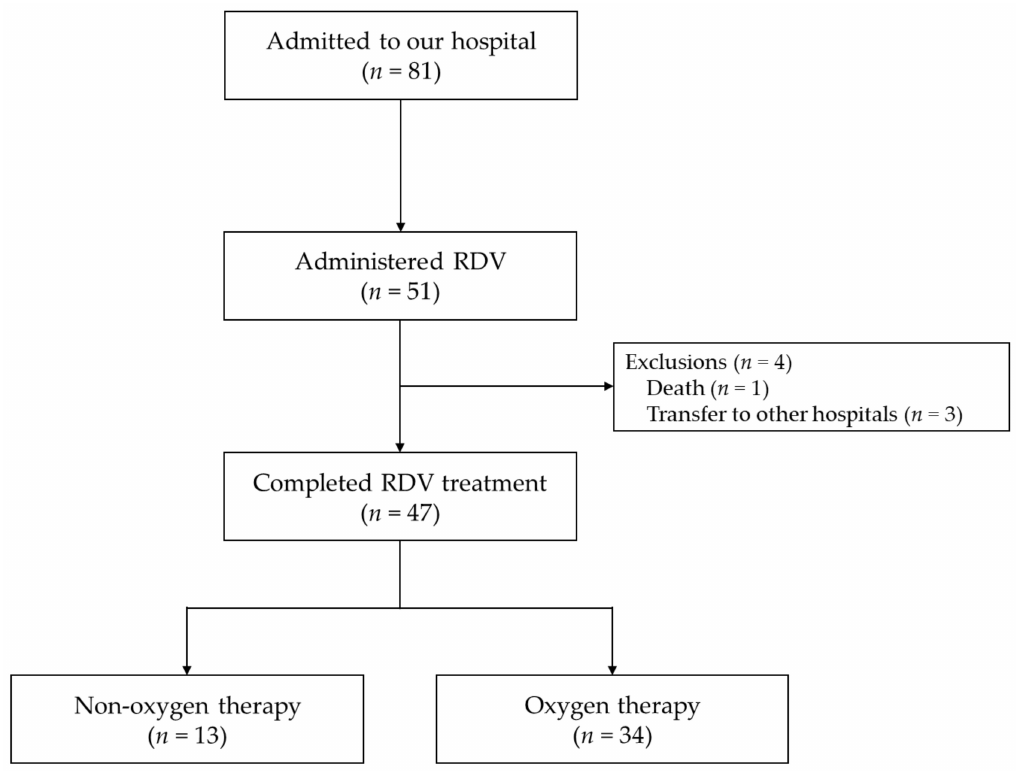
Figure 1. The study